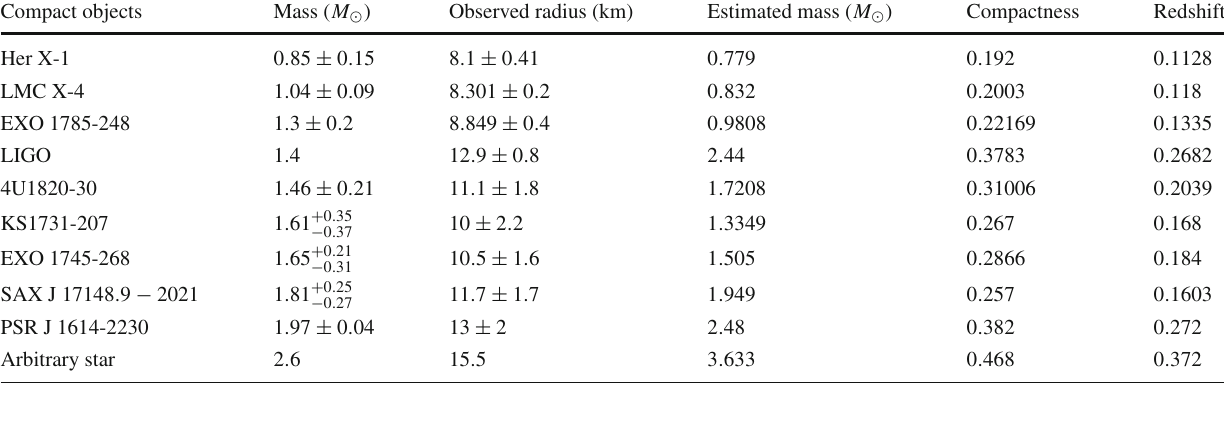
Table 2 Physical attributes of the